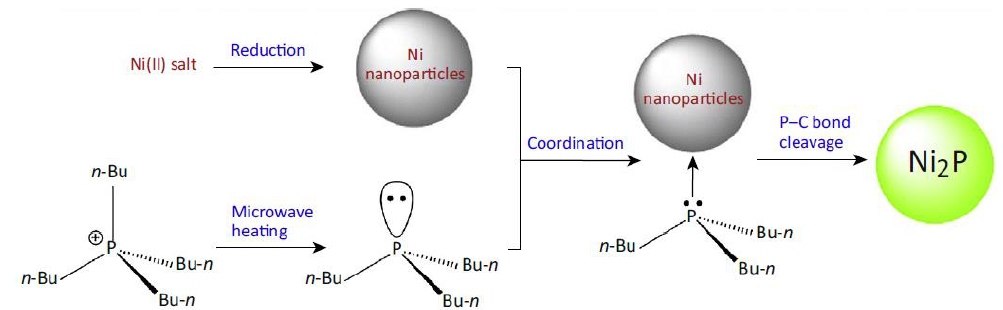
Figure 8. The mechanism for the synthesis of Ni2P nanoparticles from the [P4444]Cl ionic liquid. Reproduced from [19] with permission from Elsevier, 2021.